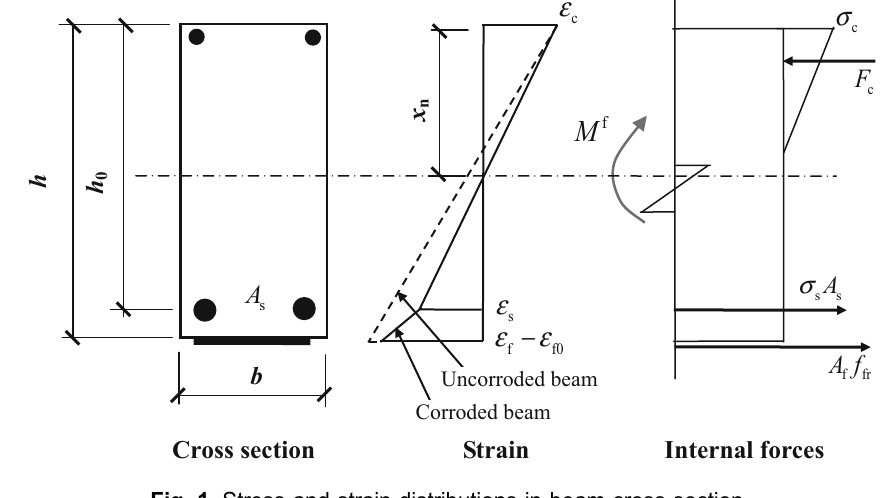
Fig. 1 Stress and strain distributions in beam cross-section.